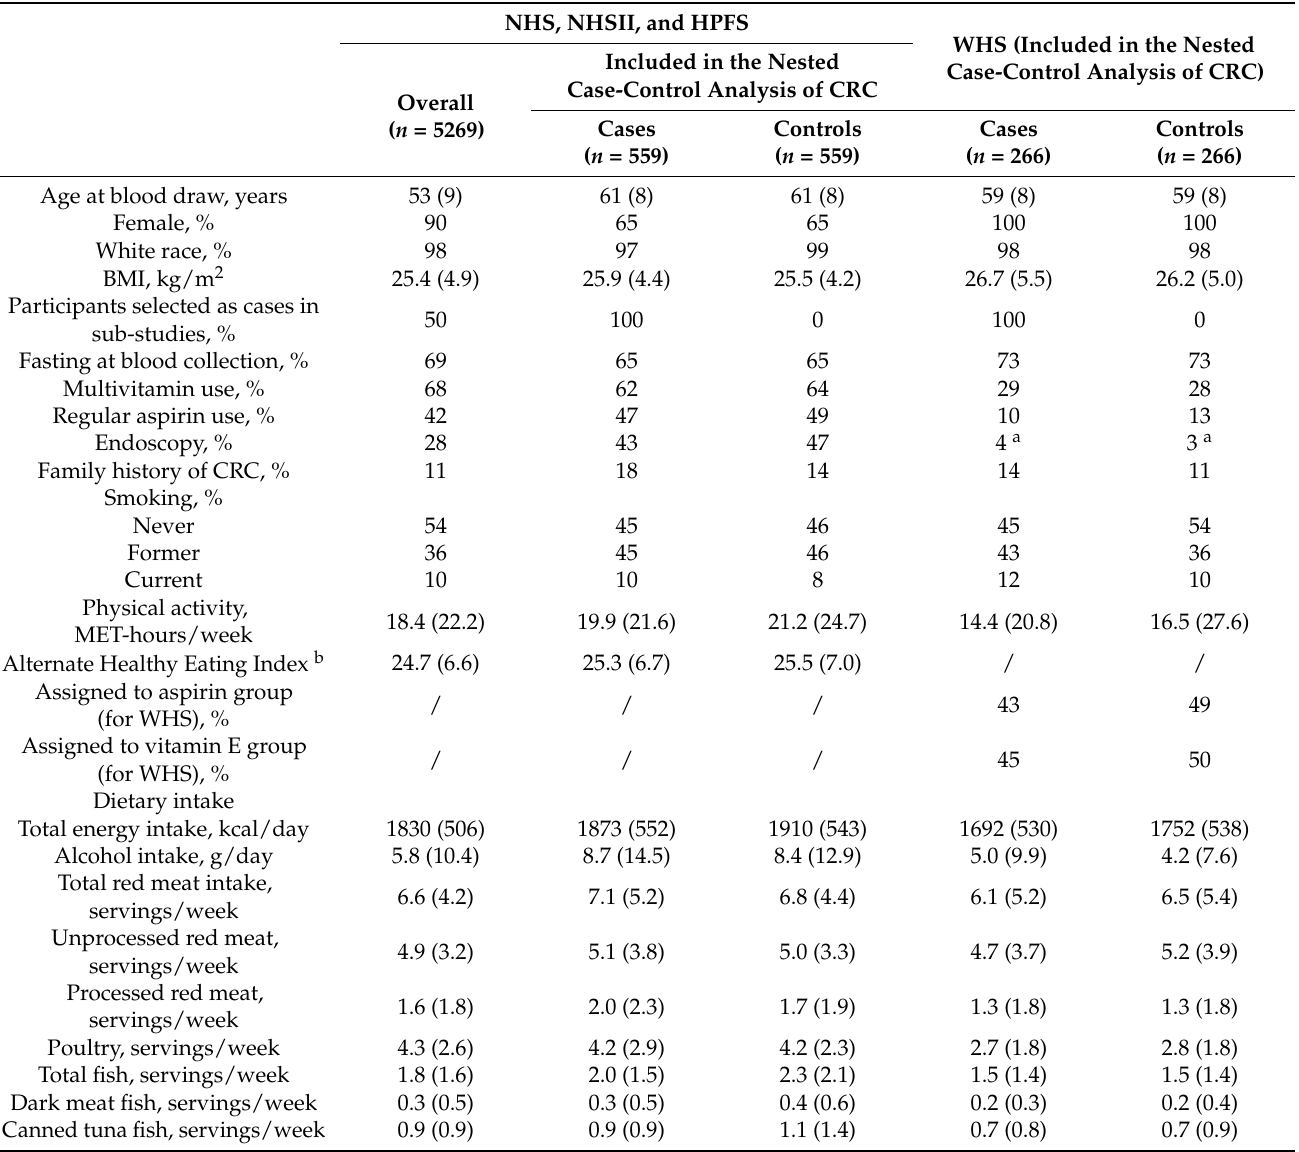
Table 1. Characteristics of the study participants in NHS, NHSII, and HPFS, and external replication participants in